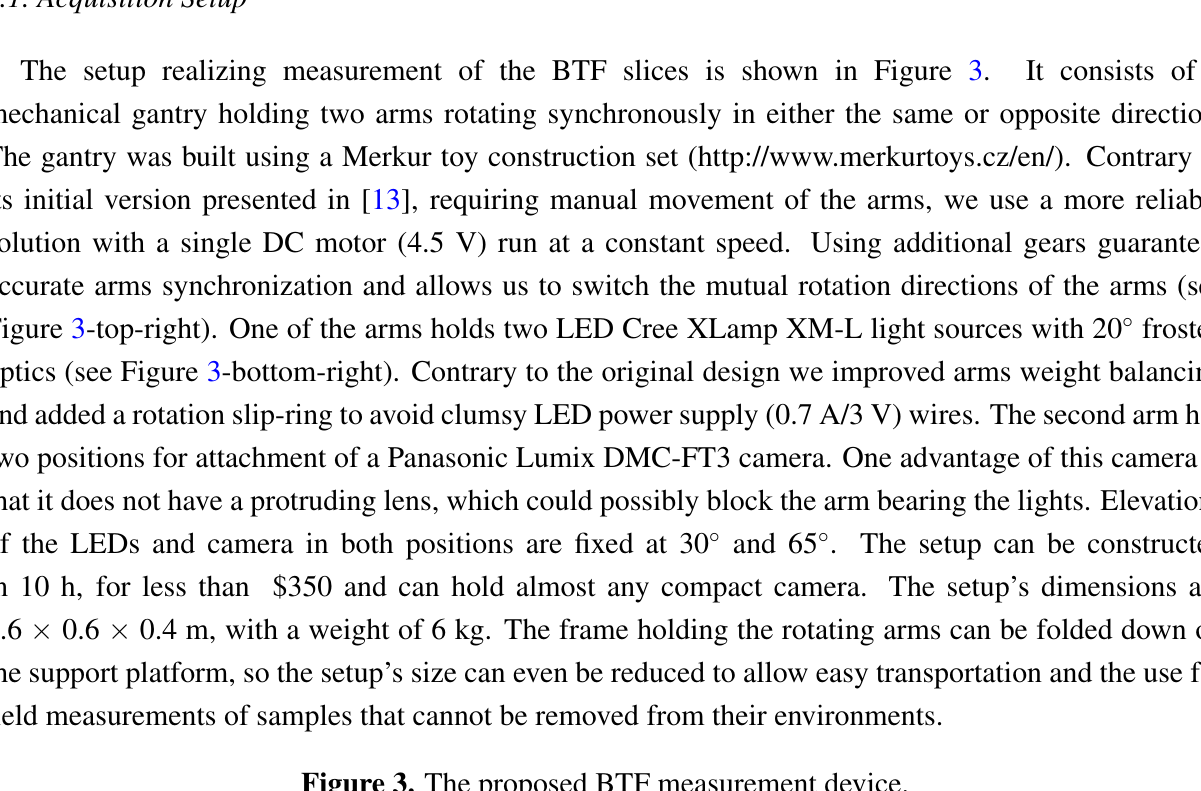
Figure 3. The proposed BTF measurement